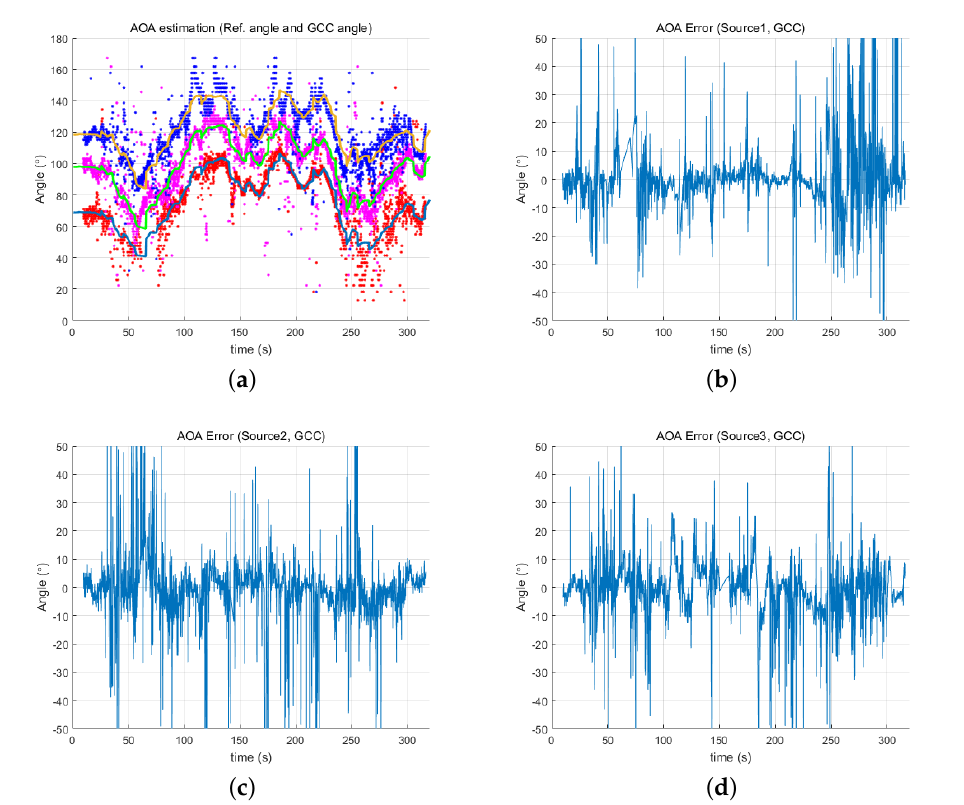
Figure 9. Error of angles determined by GCC: ( a ) reference angles and estimated angles for three acoustic sources from GCC; ( b ) error of Source 1; ( c ) error of Source 2; and ( d ) error of Source